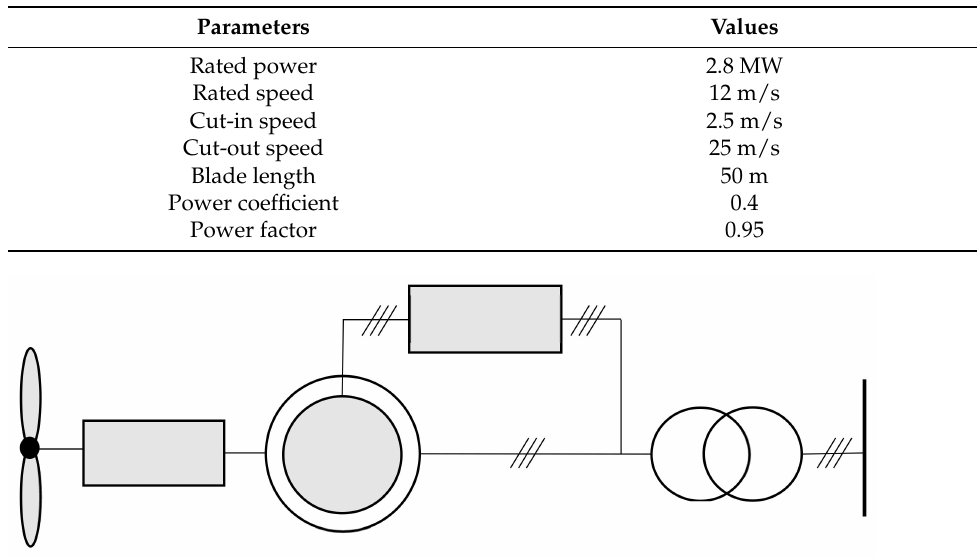
Figure 5. Histogram and modelled wind speed probability density distribution function. Table 2. Wind turbine characteristics.